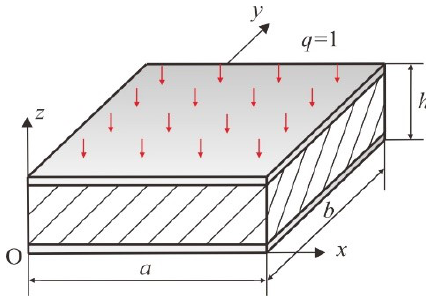
Figure 4: The geometry and coordinates of a sandwich-like